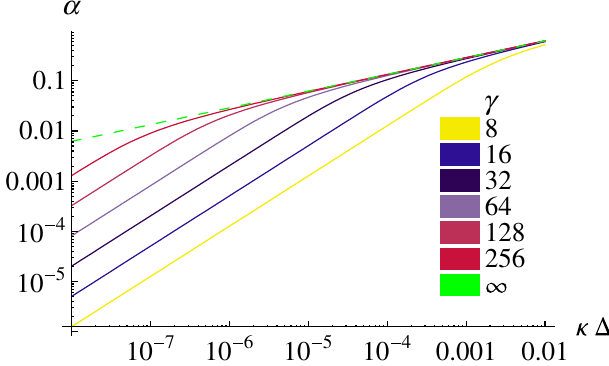
FIG. 2. (Color) The inverse of Eq. (33) for positive (cid:9) at various energies. The dashed green curve ( (cid:6) ! 1 ) is (cid:9) ¼ ð 24 (cid:7) (cid:1) Þ 1 = 3 , the inverse of Eq. ffiffiffiffiffiffiffiffiffiffiffiffiffiffiffiffiffiffiffiffiffiffiffiffiffiffiffiffiffi